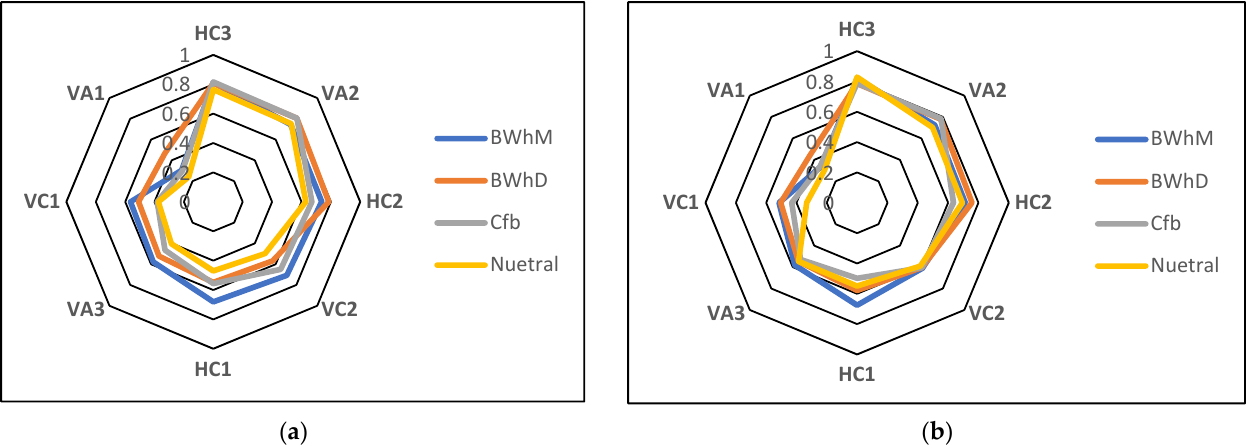
Figure 5. The ranking for the four different conditions ( a ) Based on the entropy weight for the climate ( b ) Based on average entropy weight.